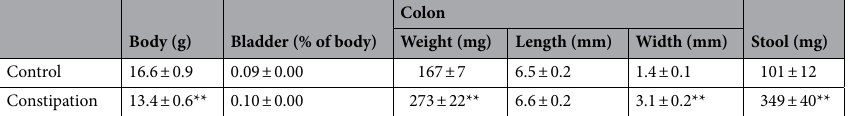
Table 2. Morphological parameters of the urinary bladder and colon in the control and the constipation groups. Mean ± SE, **p < 0.005 vs. the control